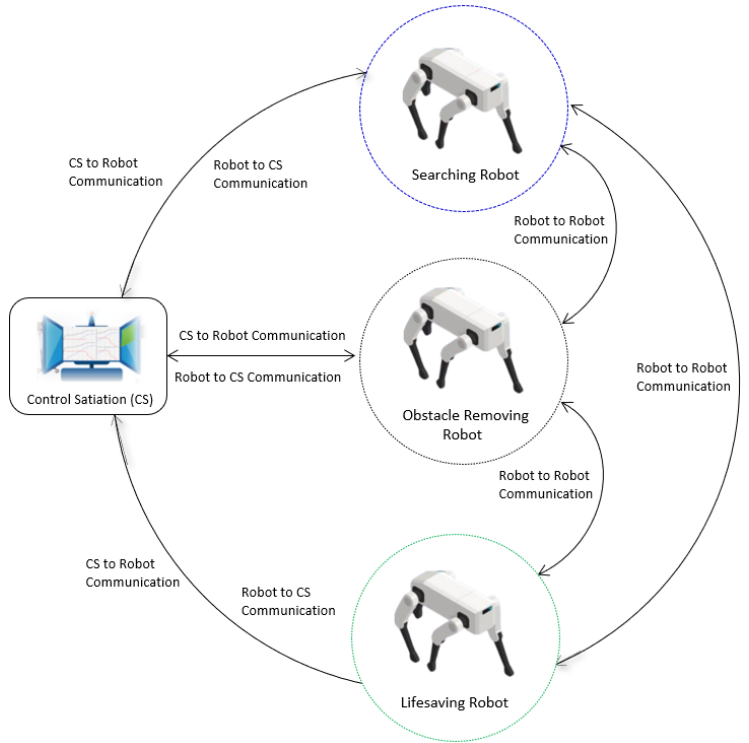
Figure 5. Human Rescue Robot System.